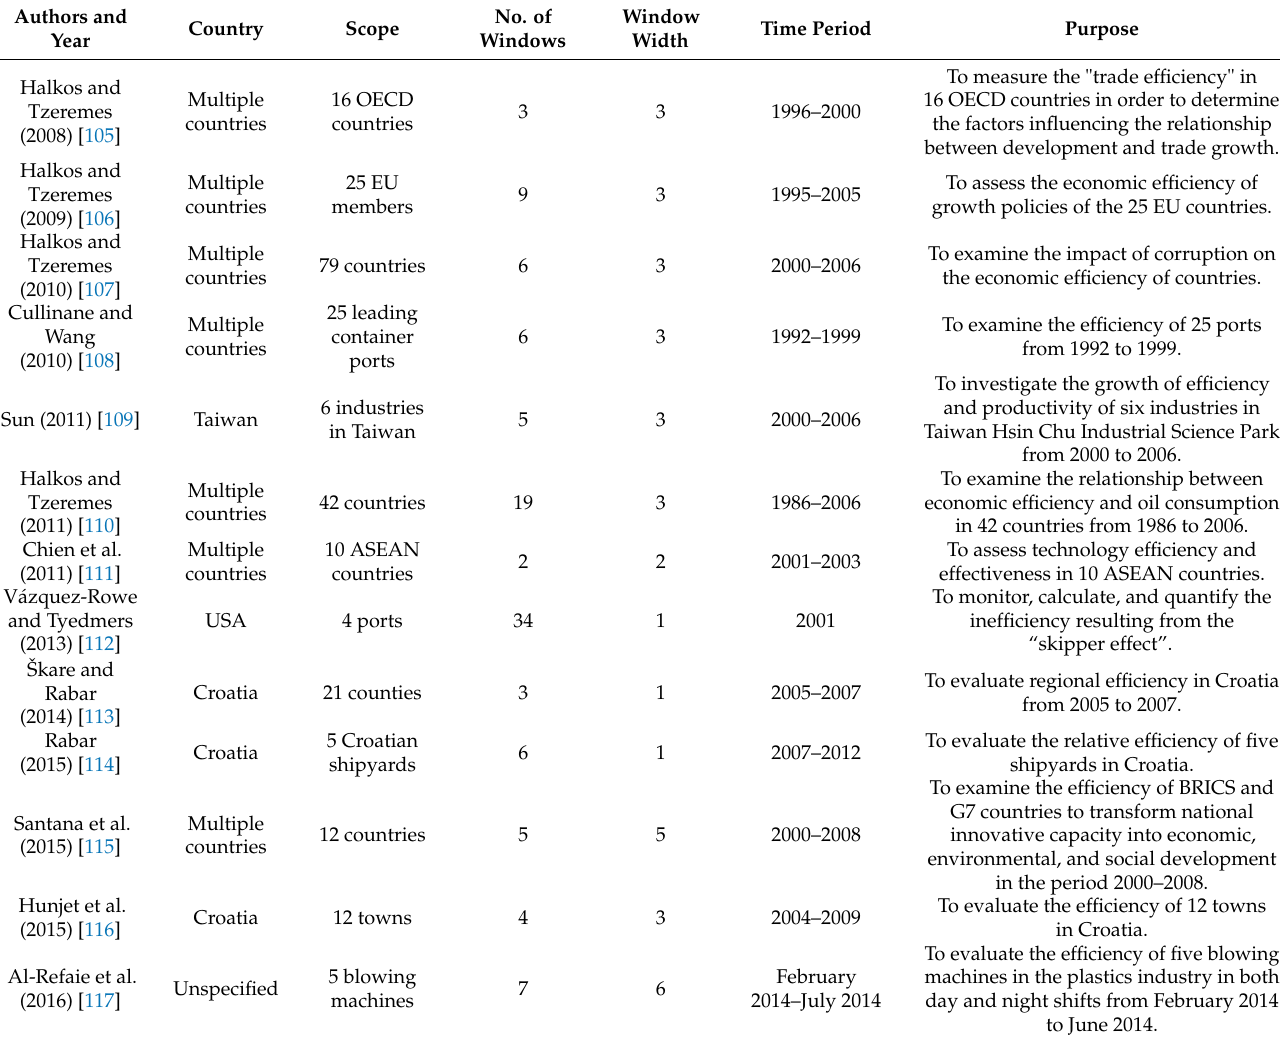
Table 17. Articles classified under the miscellaneous